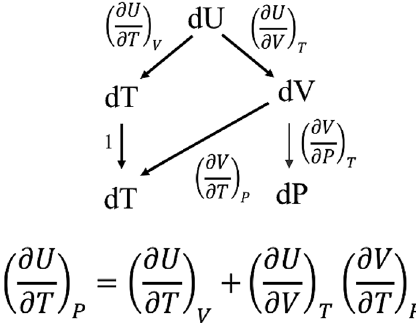
FIG. 5. Deriving the partial derivative in terms of other partial derivatives using the tree diagram